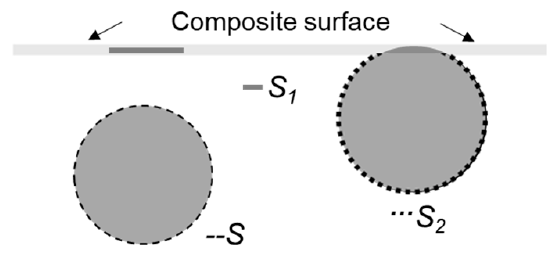
Figure 17. Scheme of changes in the contact surfaces between the polymer, nanoparticle and the melt boundary of the composite when the nanoparticle migrates to the melt boundary.